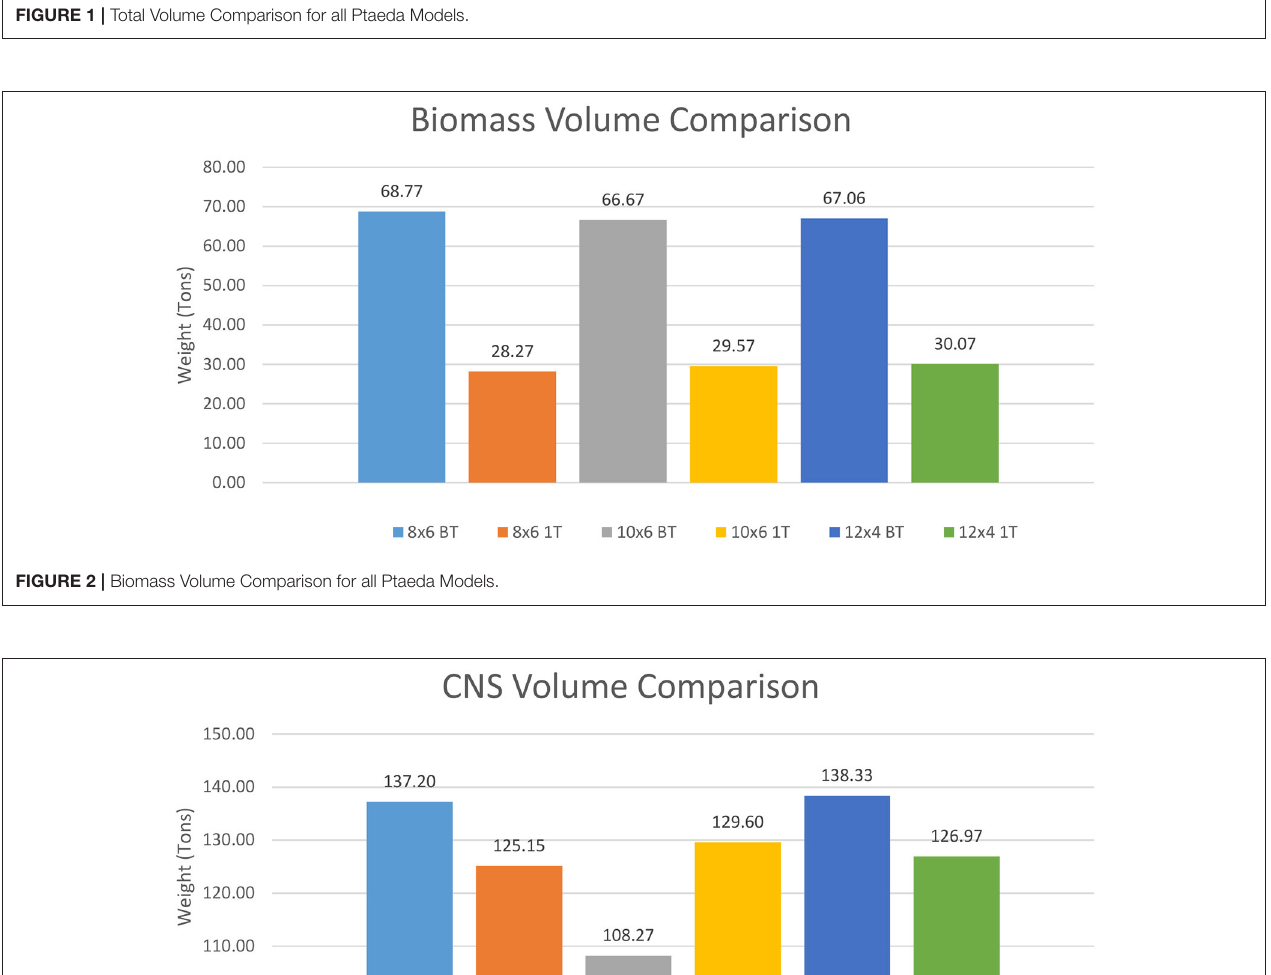
FIGURE 1 | Total Volume Comparison for all Ptaeda Models.